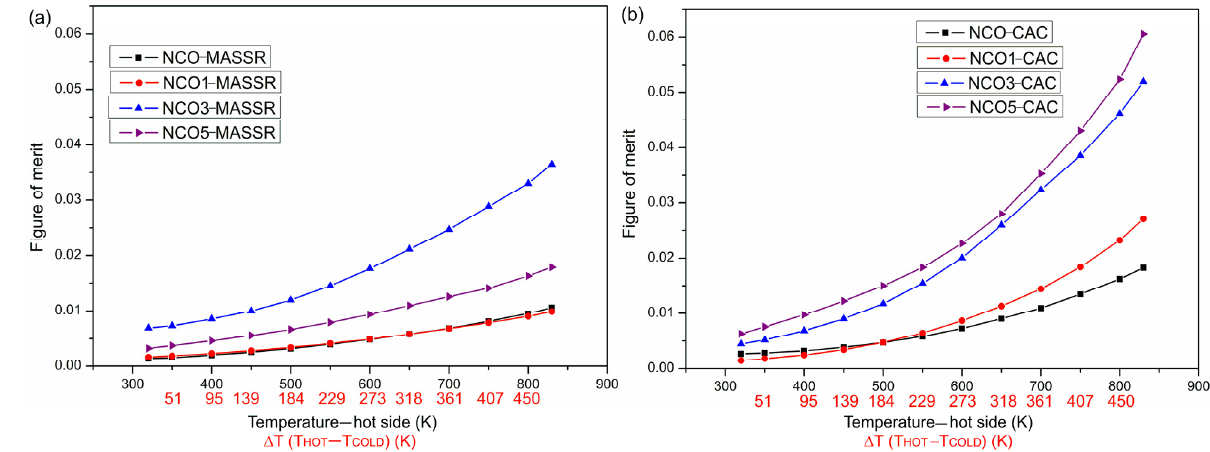
Figure 7. Temperature dependence of the figure of merit of the ( a ) MASSR and ( b ) CAC samples for the temperature gradients Δ T at the temperatures of the hot side of the samples.